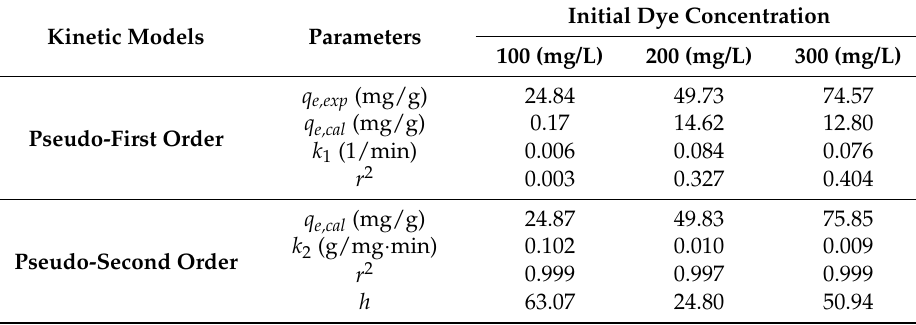
Table 2. Kinetic constants of SCC adsorption on H. communis sponge skeletons at different